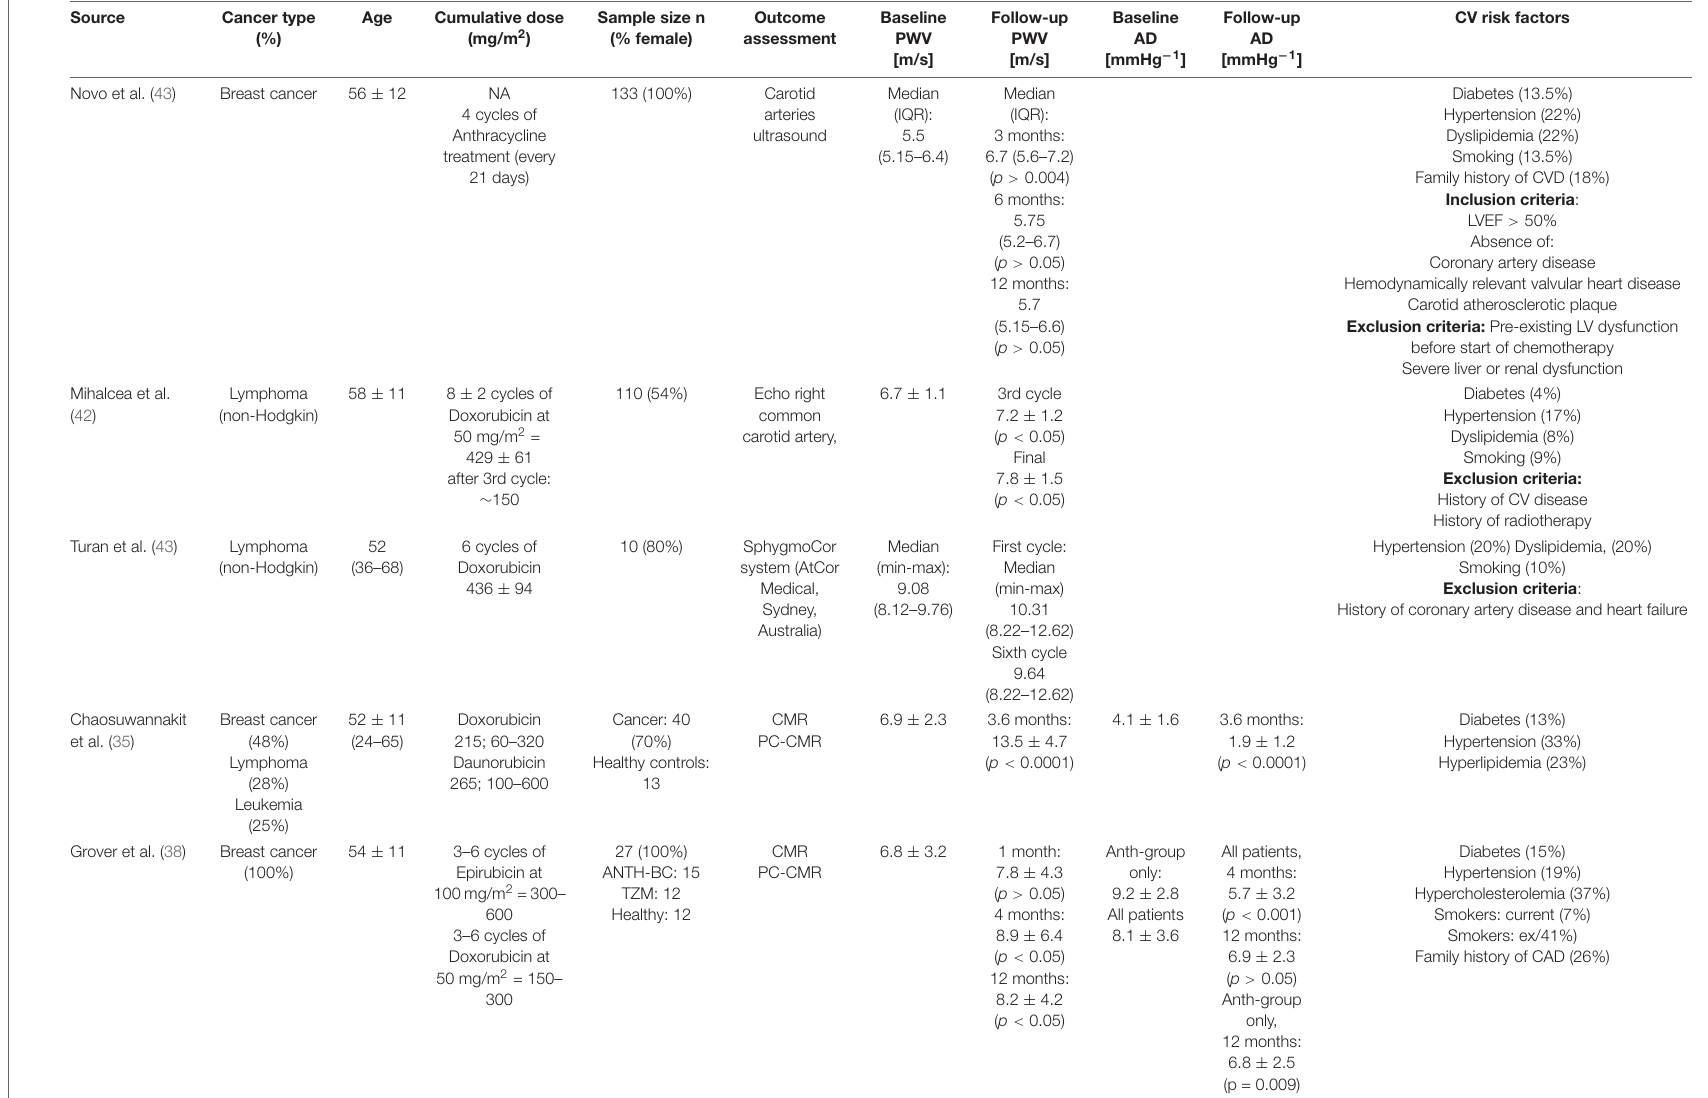
TABLE 1 | Description of the included